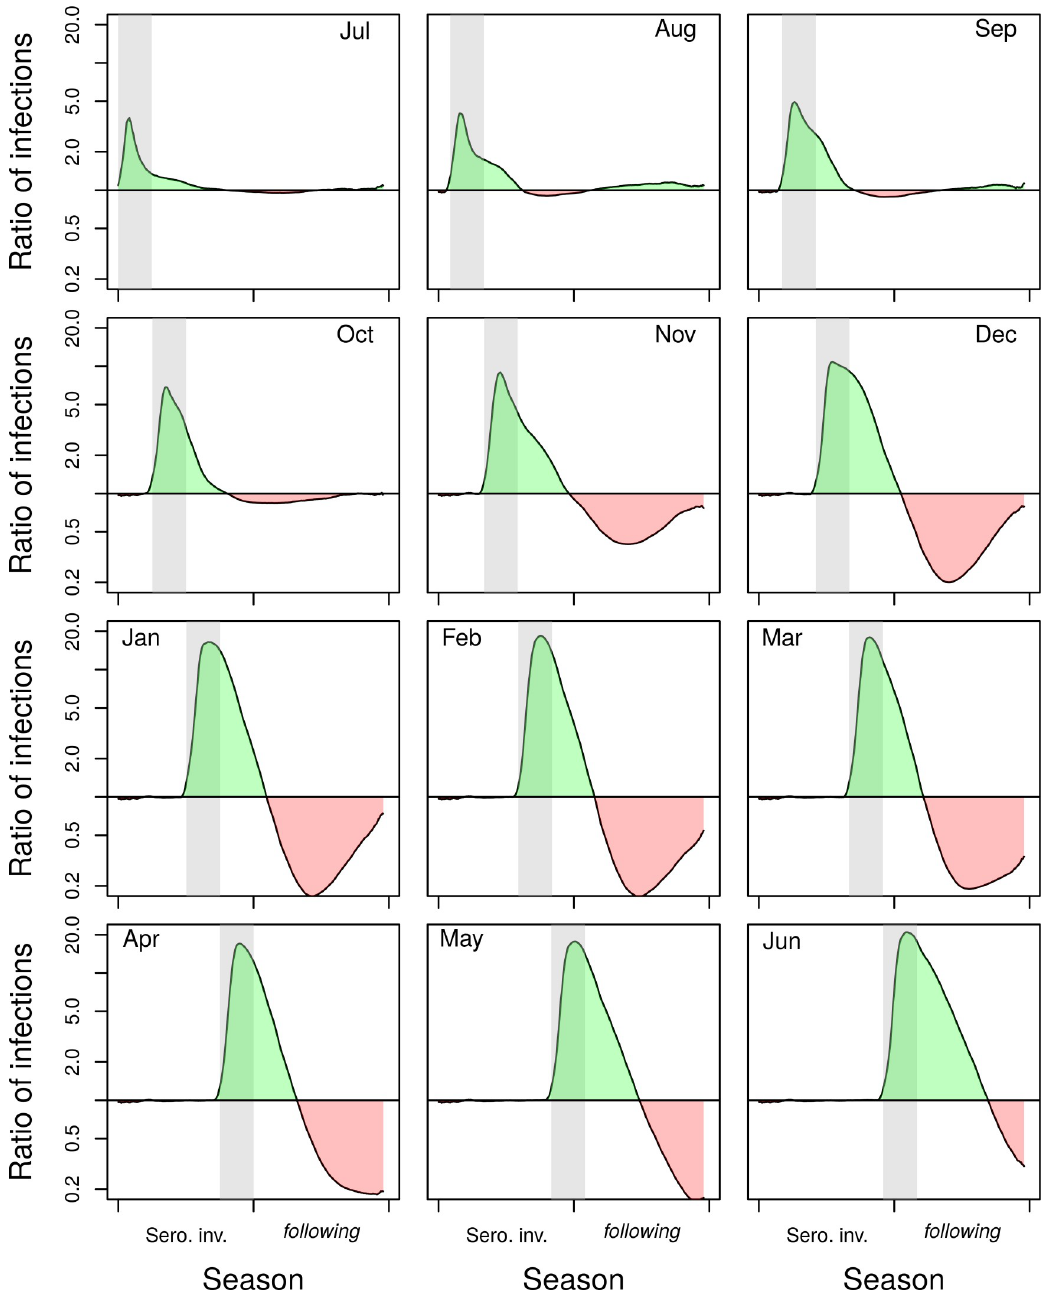
Fig 4. Ratio of the mean number of infections under lockdown without vector control to the mean number in the baseline scenario without lockdown but with vector control. Results are for the serotype invasion and following season, when lockdown is initiated in different months (shown in the top corner of the panel). When lockdown did not occur, there was a city-wide vector control campaign. Conversely, when lockdown did occur, there was no vector control campaign. Lockdown/vector control occurred during the gray band. Green shading indicates an increase in infections under lockdown without vector control, whereas red shading indicates a decrease.